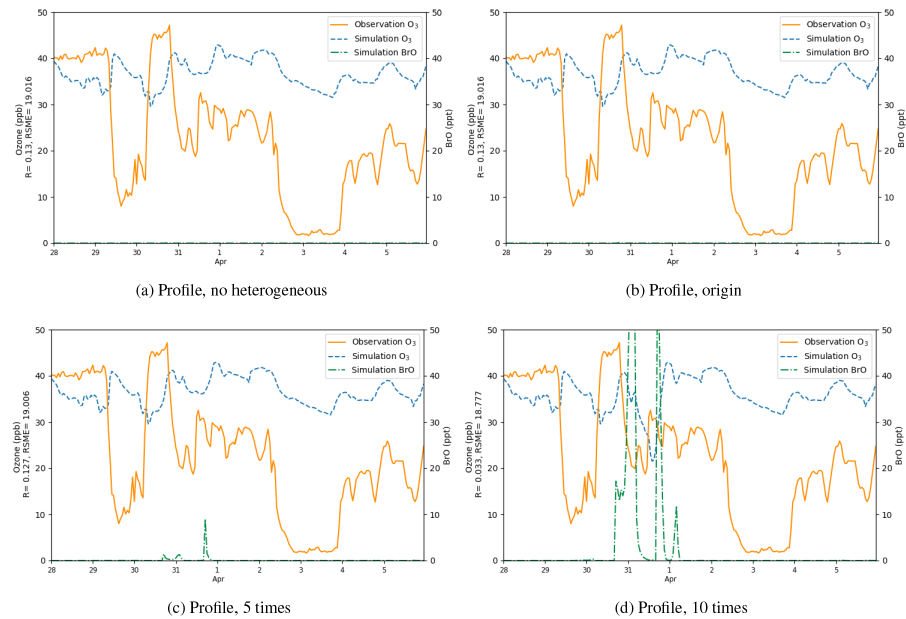
Figure 12. Surface ozone (ppb) and BrO (ppt) at Barrow from 28 March to 5 April 2019, obtained from CMAQ simulations using different heterogeneous reaction rates and the default boundary condition, i.e., a static ozone profile. The correlation coefficient R and the root-mean- square error RMSE are also presented on the vertical